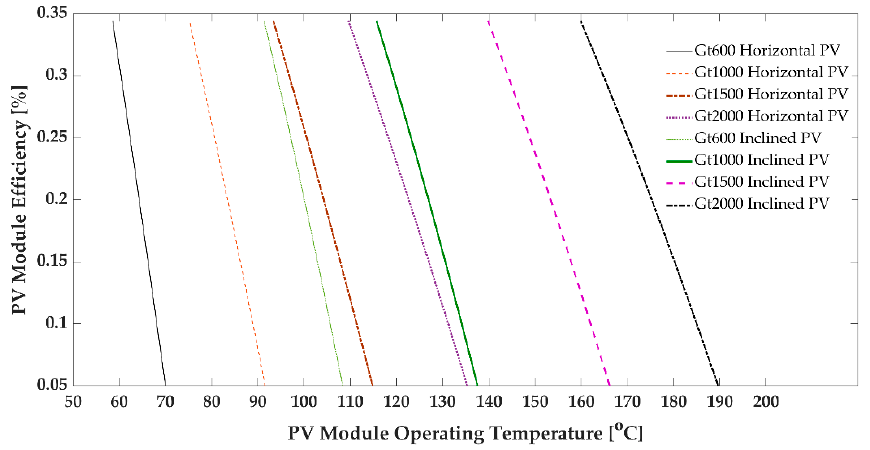
Figure 6. PV module efficiency vs. PV module operating temperature with specified solar flux at γ = 90° on the horizontal module and inclined PV module with θ = 30° .